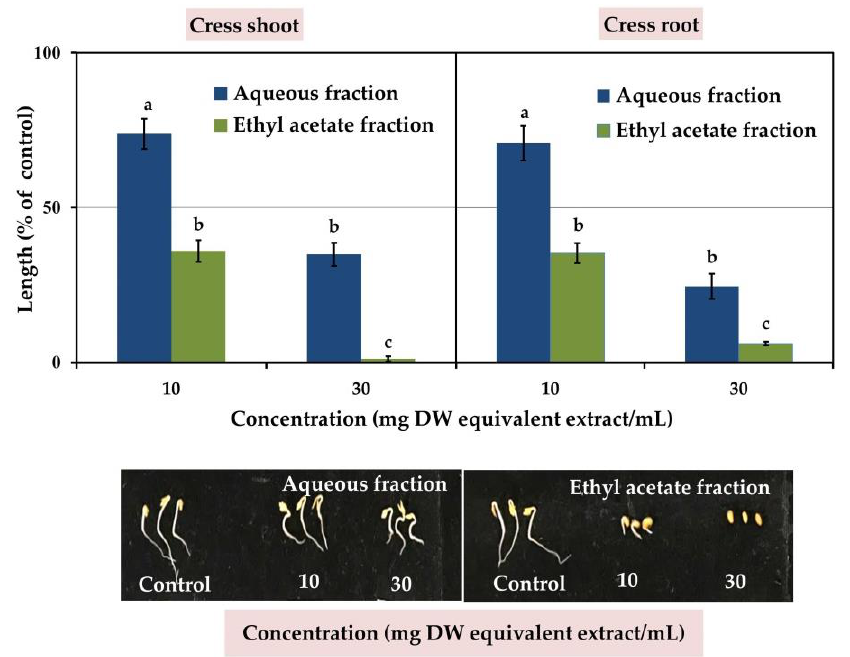
Figure 3. The inhibitory effect of the aqueous and ethyl acetate fractions obtained from Marsdenia tenacissima on the shoot and root growth of cress in partition. The bars on each experiment express mean ± SE with three replicates ( n = 30). Different letters indicate significant differences among the treatments (Tukey’s HSD, p < 0.05).